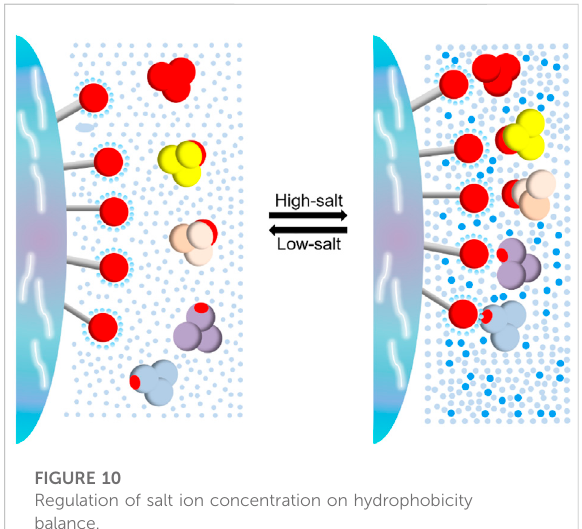
FIGURE 10 Regulation of salt ion concentration on hydrophobicity